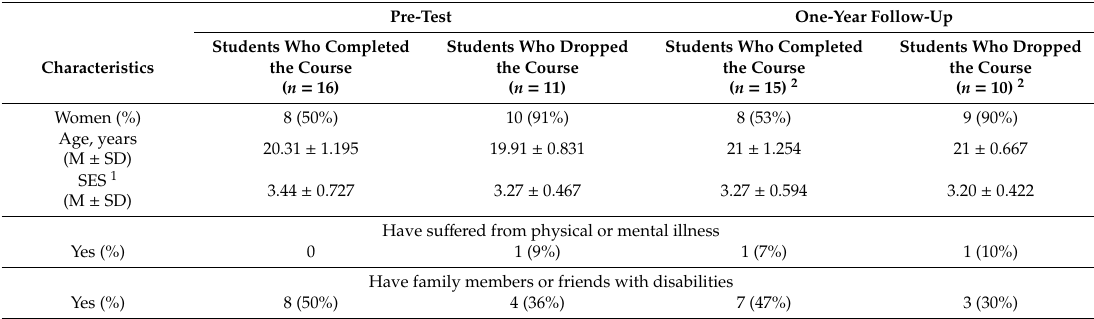
Table 2. Participant characteristics.